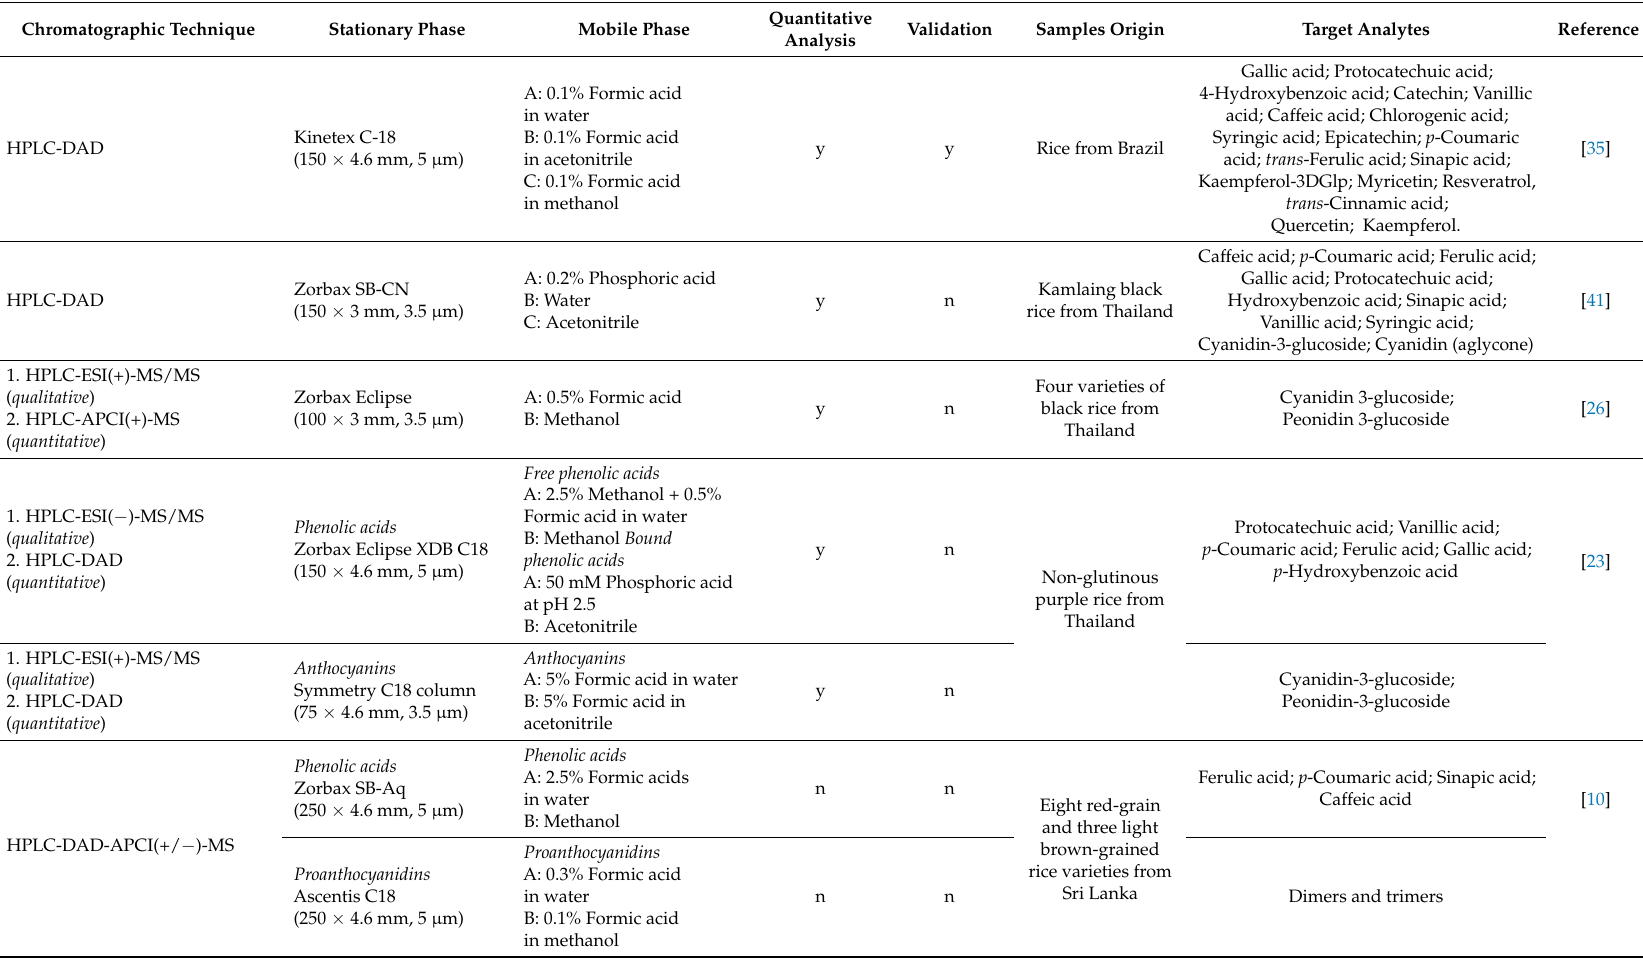
Table 1. Selected HPLC methods for the determination of phenolic compounds in